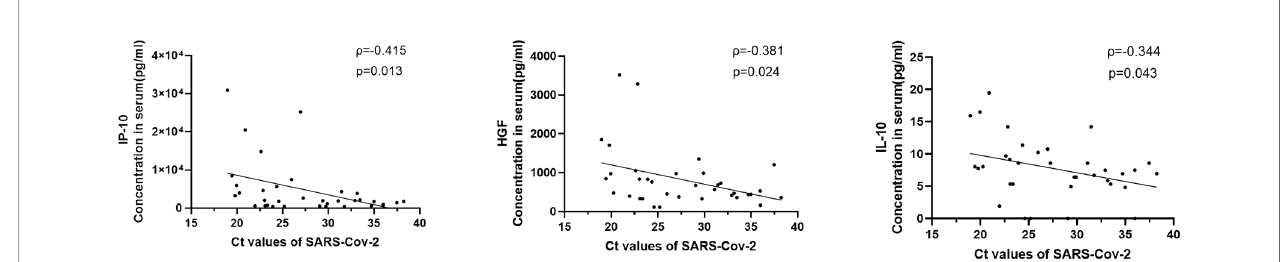
FIGURE 2 | Correlations between serum cytokine level and virus titers in COVID-19 patients. The virus quantitative detection results were expressed by CT value for the SARS-CoV-2 gene by quantitative real-time reverse transcription-PCR as previously described. Viral loads from 35 patients within 2 weeks after disease onset were acquired. The levels of 3 cytokines, including IP-10, HGF and IL-10, were positively correlated with the virus titers.